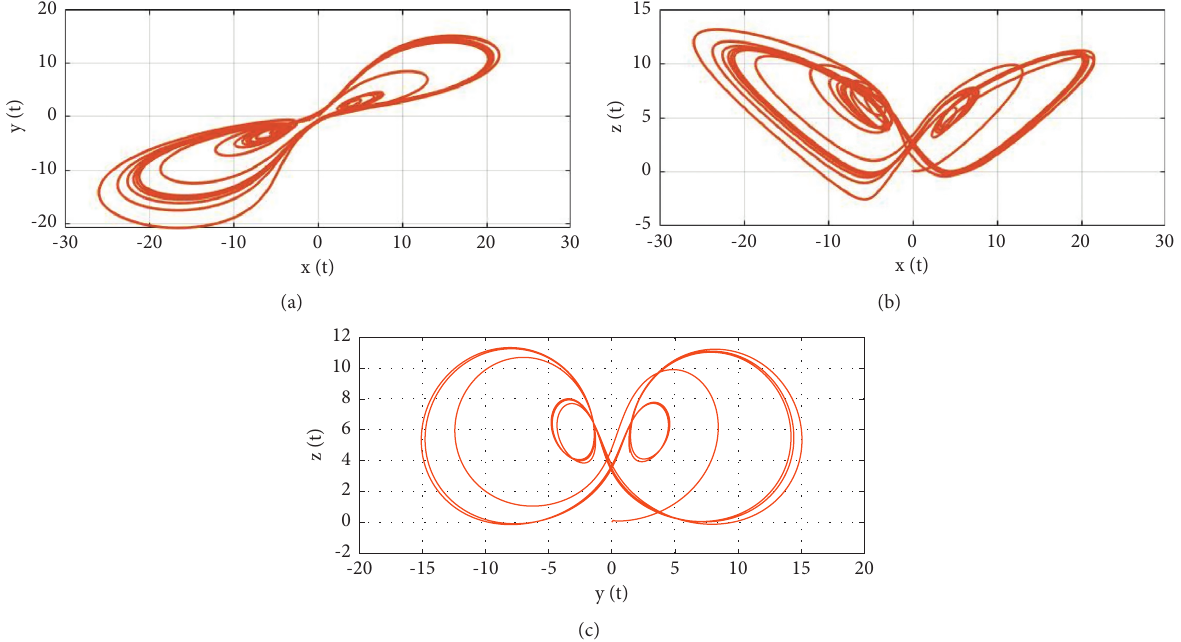
Figure 2: Phase portraits of system (25) for derivative order of q � 0.98 projected on different planes. (a) x - y plane. (b) x - z plane. (c) y - z